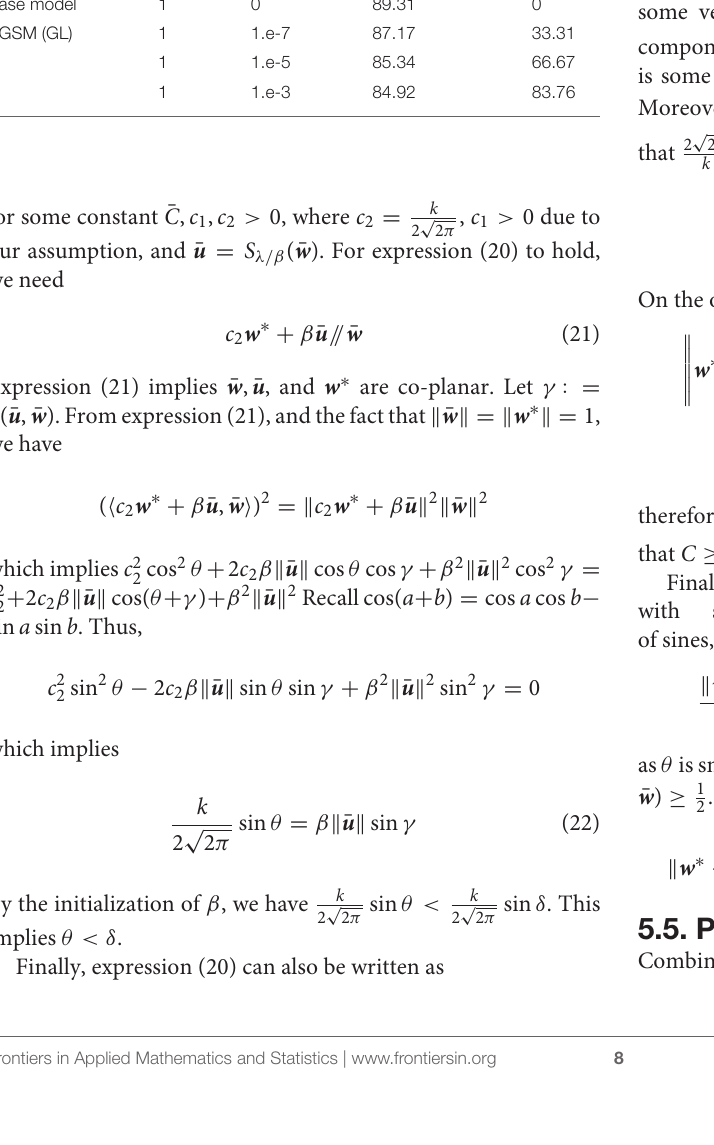
TABLE 1 | Accuracy and sparsity of RVSCGD on a LeNet variation, on the MNIST dataset. Penalty β λ Accuracy Sparsity Base model 1 0